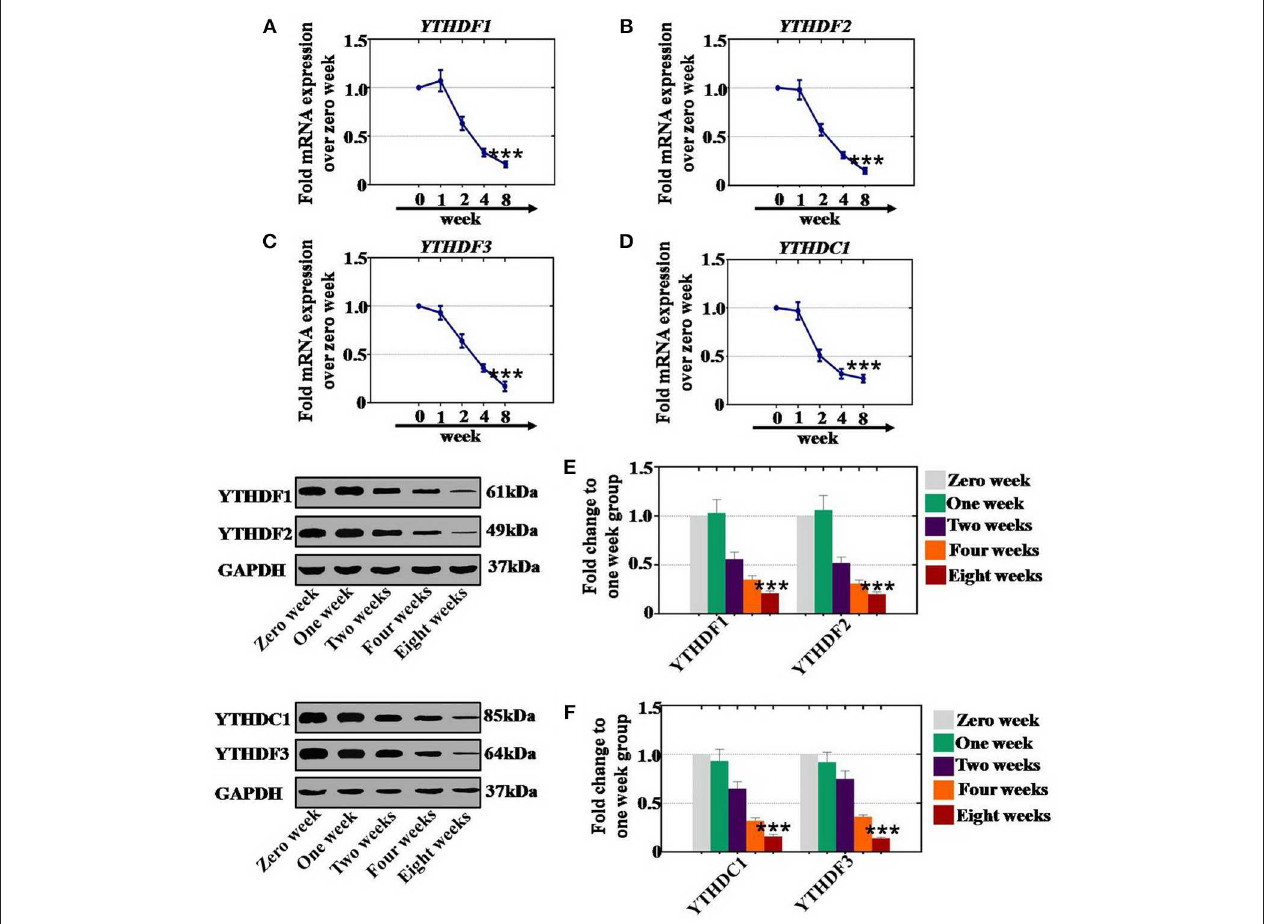
FIGURE 8 | Quantification and time-dependence analysis of the RNA effector expression levels after CTX treatment in vivo . (A–D) The mRNA expression levels of YTHDF1, YTHDF2, YTHDC1, and YTHDF3 in human. (A–D) Ovary were tested after treatment with 120 mg/kg CTX from 0 to 8 weeks. (E) The western blot method determined the expression levels of YTHDF1 and YTHDF2 in human ovary after treatment with 120 mg/kg CTX from 0 to 8 weeks. (F) The western blot method determined the expression levels of YTHDC1 and YTHDF3 in human ovary after treatment with 120 mg/kg CTX from 0 to 8 weeks. All experiments were performed three times. The error bars indicate SD; *** p < 0.001 (compared with the control group).